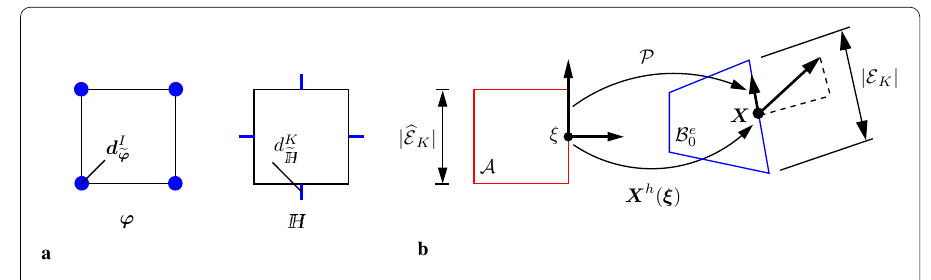
Fig. 3 Q 1 RT 0 Raviart–Thomas finite element and its mapping from the parametric to the physical space. a The deformation map ϕ is continuously interpolated using node-based Q 1 shape functions. The solvent-volume flux H is approximated using edge-based RT 0 shape functions. b To obtain the RT 0 shape functions and their derivatives in the physical space, a Piola transformation from the parametric space according to (21) is considered